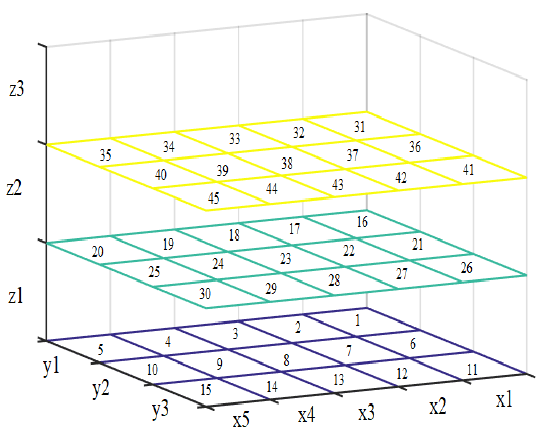
Figure 3. Regions formed on the soccer field for the location of the